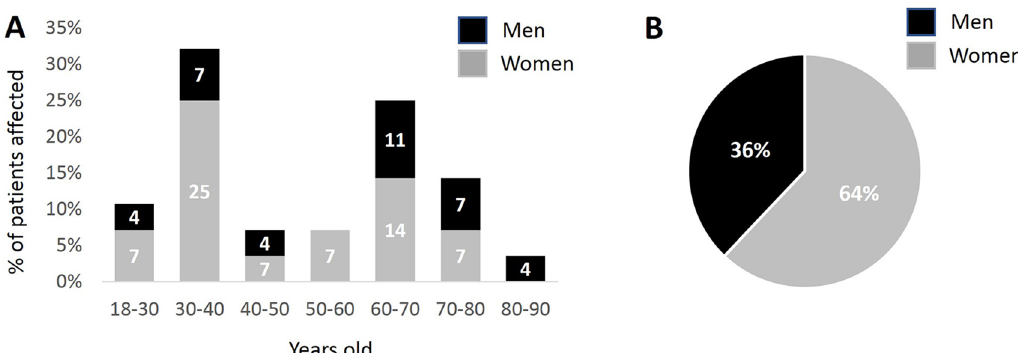
Fig. 2. Epidemiological aspect of oral LyP cases reported in the literature according to sex and age groups.